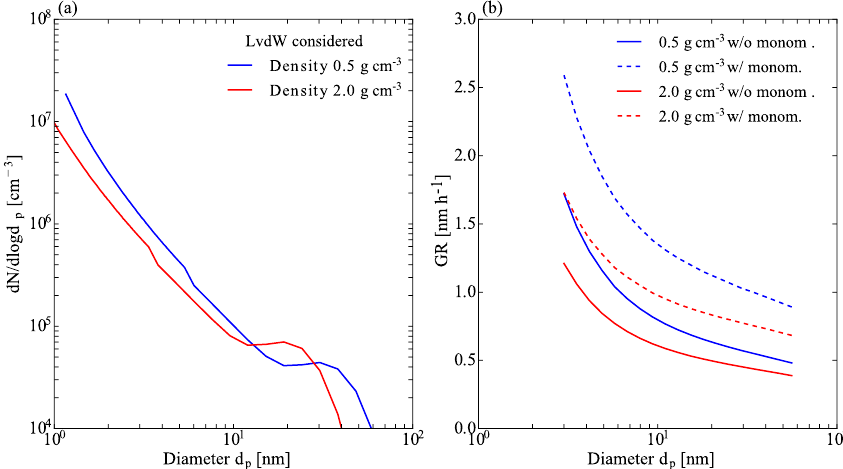
Figure D1. Effects of sub- d p , min particles. (a) Number size distribution derived from dimensionless results calculated for a collision- controlled limit according to McMurry and Li (2017). LvdW stands for London van der Waals forces, which are taken into account in calculating the resulting size distributions. (b) GR (nmh − 1 ) resulting from collisions with sub- d p , min particles as a function of particle di- ameter for particle density of 0.5 and 2gccm − 1 . Further, collisions with monomers are considered (w/monom.) and neglected (w/o